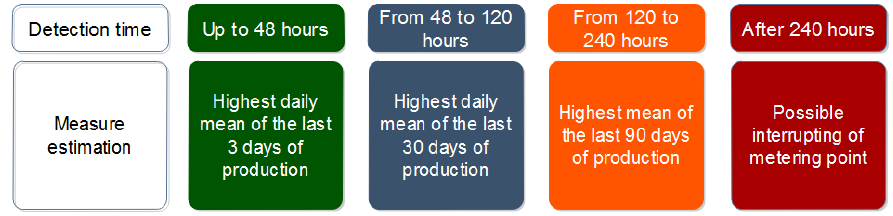
Figure 3. Measure estimation methodology used by the regulatory